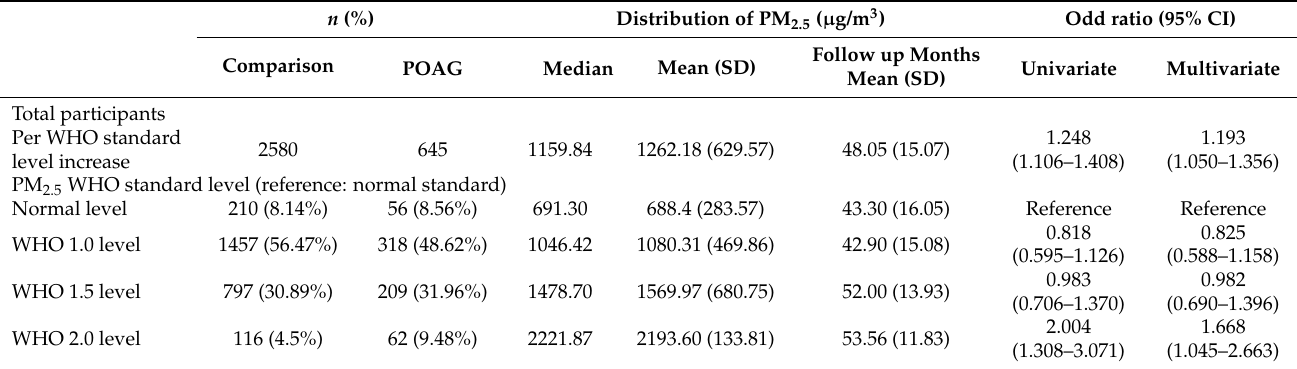
Table 3 expresses the risks of confounding variables that were used to adjust the PM 2.5